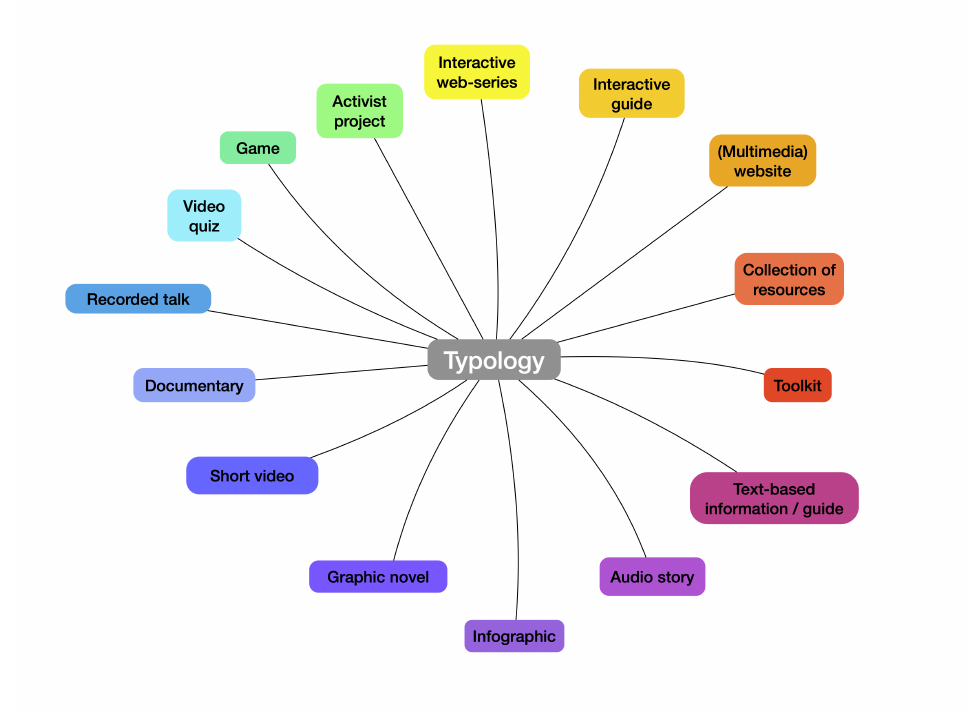
Figure 2: Typology with